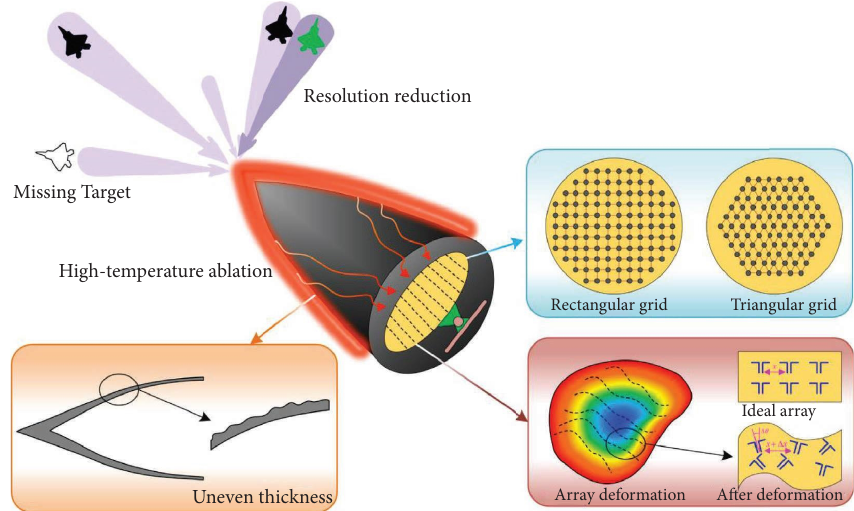
Figure 9: Structural-electromagnetic-thermal coupling of the APAA in